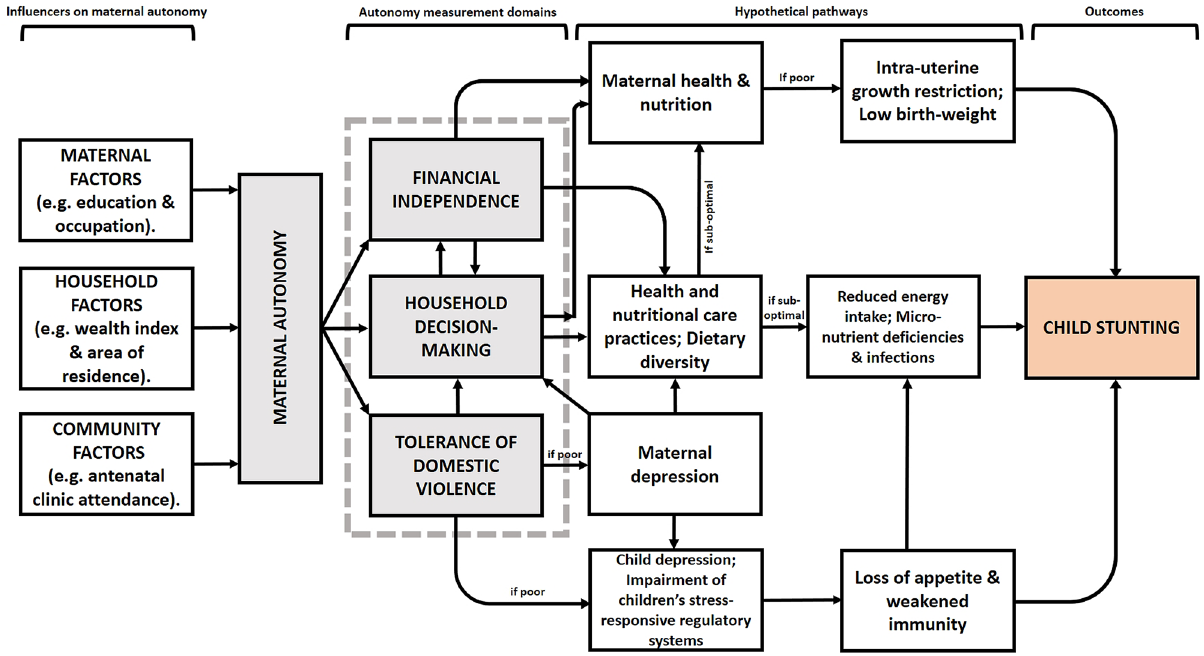
Figure 1. Conceptual framework for pathways linking maternal autonomy and child